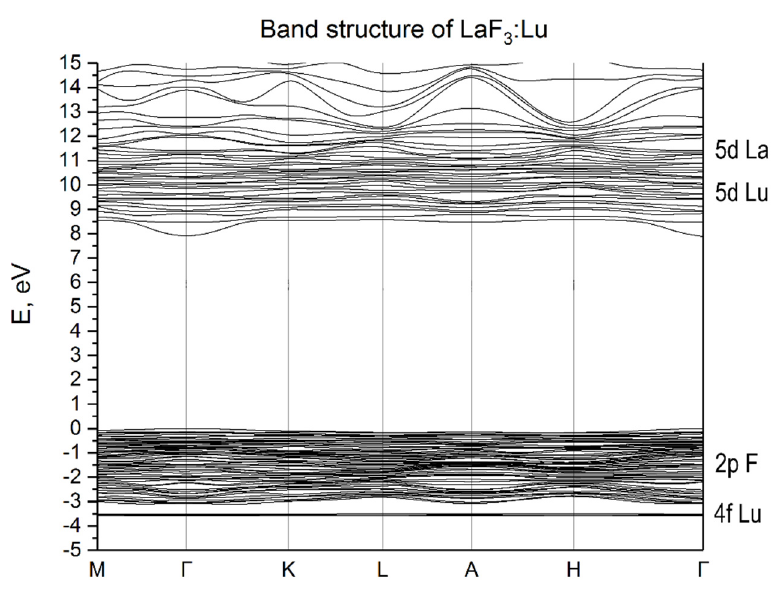
Figure 4. The energy band structure of LaF 3 :Lu.